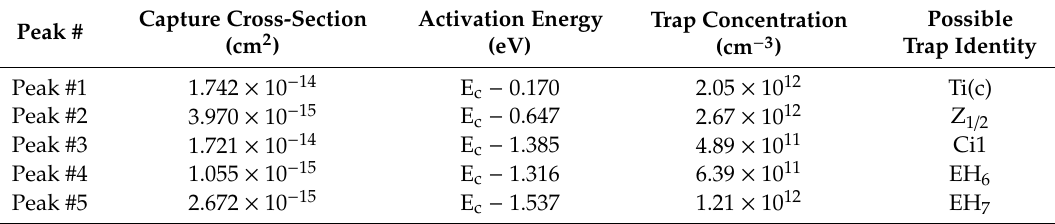
Table 4. Defect parameters acquired from the DLTS spectra for a 20 µ m n-type Ni / 4H-SiC epitaxial (n-S20) Schottky barrier detector.